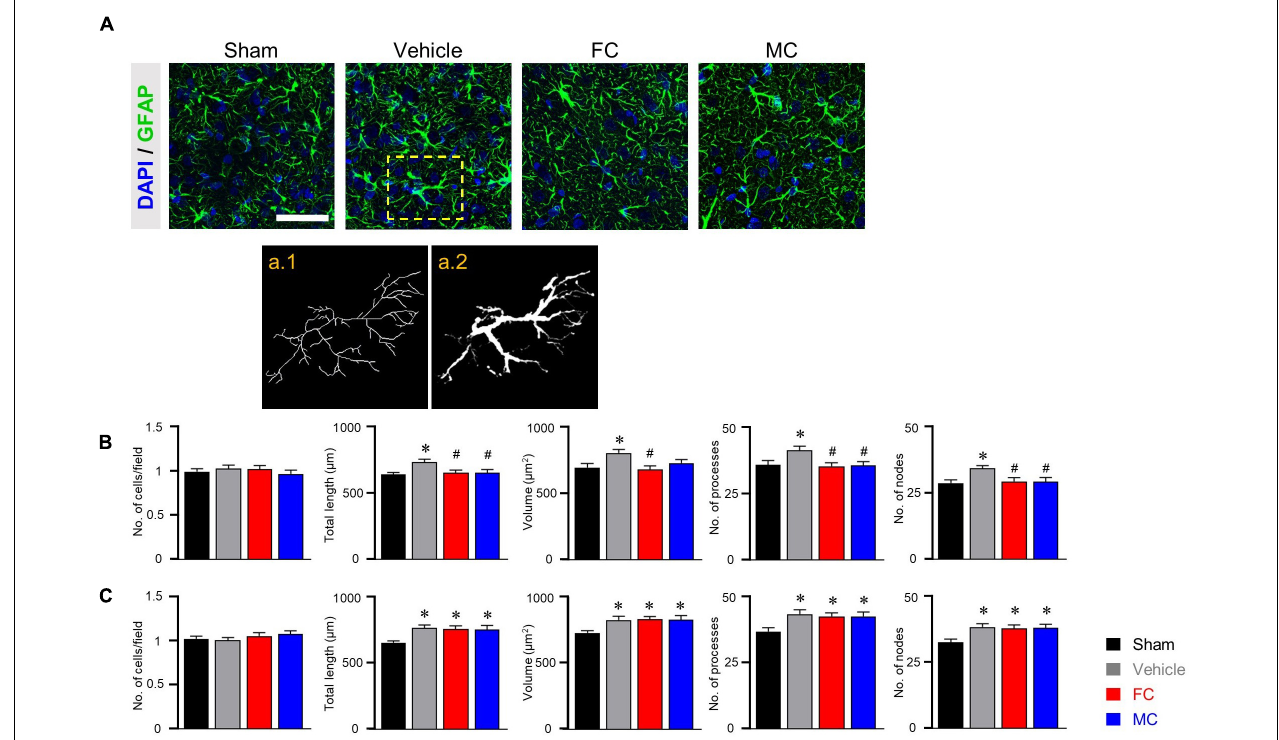
FIGURE 3 | Morphometric alterations of astrocytes after early inhibition. (A) Representative immunofluorescence images of GFAP-positive astrocytes with cellular nuclear marker DAPI in the IC on PID 7. Scale bar, 50 µ m. Increased complexity of astrocyte morphology was seen in the vehicle group compared to the sham-operated group (a.1 and a.2 represent the transformed skeletal image and volume reconstruction image of astrocytes, respectively, from yellow dotted box in the vehicle group). (B,C) Both FC and MC interrupted the morphological activation of astrocytes in the early stage of pain development ( B: PID 7; C: PID 14). Total length, volume, number of processes, and number of nodes were quantified by the Sholl analysis protocol (sham, vehicle, FC, and MC; each group n = 4). Error bars are SEM; ∗ p < 0.05 vs. sham; # p < 0.05 vs. vehicle; one-way ANOVA followed by Tukey’s post hoc multiple comparison